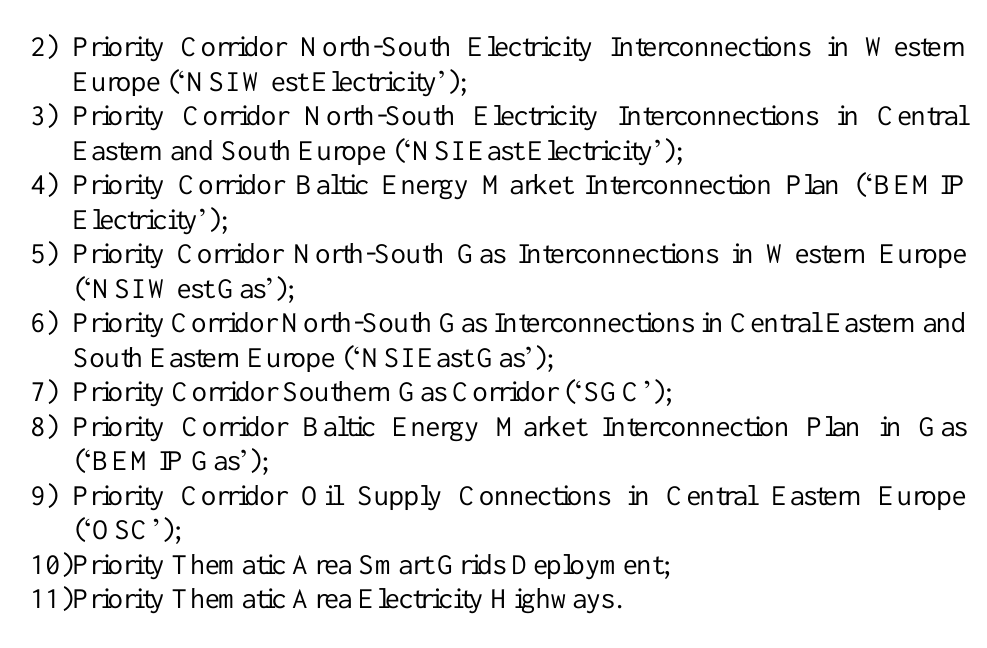
Table 1. The List of the Projects of Common Interest in Poland (developed by the author, based on EC, 2017a; EC,